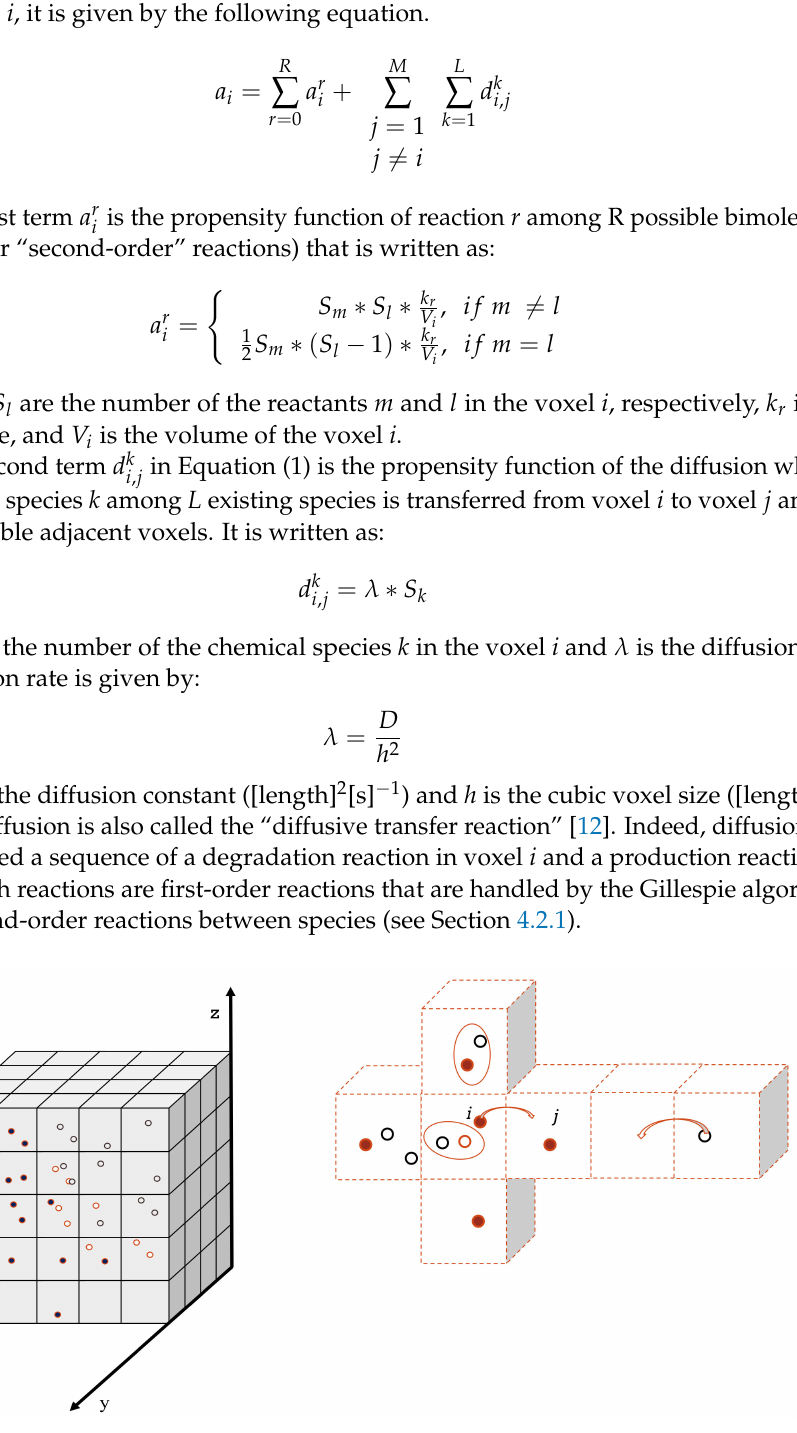
Figure 7. ( Left )/Voxelization of the considered volume of simulation into smaller sub-volumes. Species are represented by different types of circles. ( Right )/The reactions and diffusion are triggered independently in a random